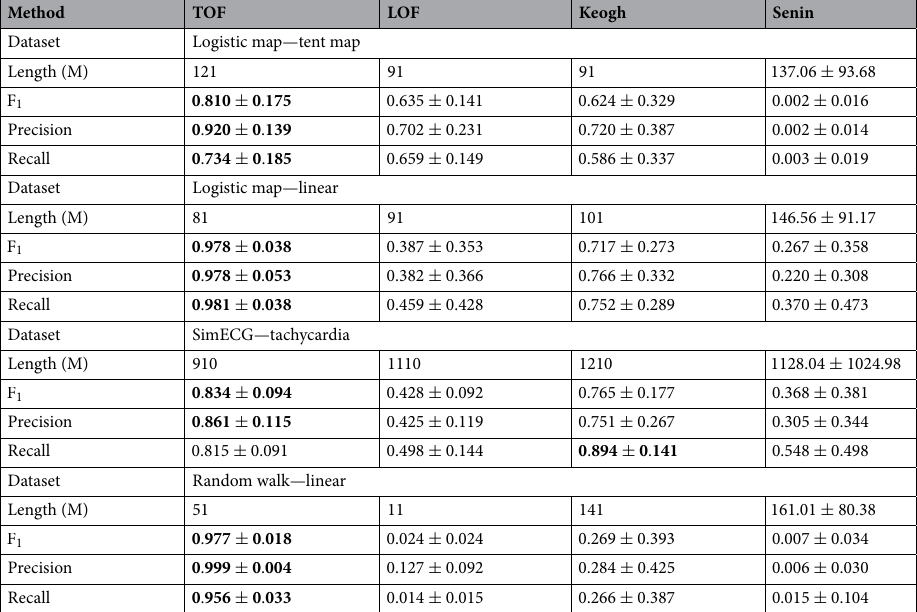
For all the four test datasets, TOF algorithm reached higher maximal F 1 scores than the LOF and Keogh’s discord detection method (Fig. 3B, Fig. S8, orange lines). The maximal F 1 score was even higher than the theo- retical limit imposed by the variable anomaly lengths to the other methods. Similar to the results on ROC AUC values, the performance of the TOF algorithm was excellent on the linear type anomalies and very good for the logmap-tent map and the simulated ECG-tachycardia datasets. In contrast, the LOF algorithm showed good performance on the logmap-tent map data series and mediocre results on logmap-linear anomalies and on the ECG-tachycardia data series. The linear outlier on random walk background was completely undetectable for the LOF method (Fig. 3B, Fig. S8, blue lines). Keogh’s discord detection algorithm displayed good F 1 scores on three datasets, but weak results were given in case of the linear anomaly on the random walk background (Fig. 3B, Fig. S8, red lines). The simulated ECG dataset was the only one, where any of the competitor methods showed comparable per- formance to TOF: Keogh’s brute force discord detection reached its theoretical maximum, thus TOF resulted in an only slightly higher maximal F 1 score in an optimal range of the length parameter. If the expectation significantly overestimated the actual length, the results of discord detection were slightly better. The F 1 scores reached their maxima when the expected anomaly length parameters were close to the mean of the actual anomaly lengths for all algorithms and for all detectable cases when the F 1 score showed significant peaks (Table 2). As we have seen, the variable and unknown length of the anomalies had a significant effect on the detection performance of all methods, but especially LOF and brute force discord detection. Senin et al. 20,46 extended the discord detection method to overcome the problem of predefined anomaly length and to allow the algorithm to find the length of the anomalies. Thus, we have tested Senin’s algorithm on our test data series and included the anomaly lengths found by this algorithm as well as the performance measures into the comparison in Table 2. While the mean estimated anomaly lengths were not far from the mean of the actual lengths, the performance of this algorithm lags well behind all three previously tested ones on all four types of test data series. We have identified several factors, which could explain the different detection patterns of different algorithms. Table S1 shows that the tent map and the tachycardia produce lower density, thus more dispersed points in the state space, presumably making them more detectable by the LOF. In contrast, linear segments resulted in a similar density of points to the normal logistic activity or a higher density of points compared to the random